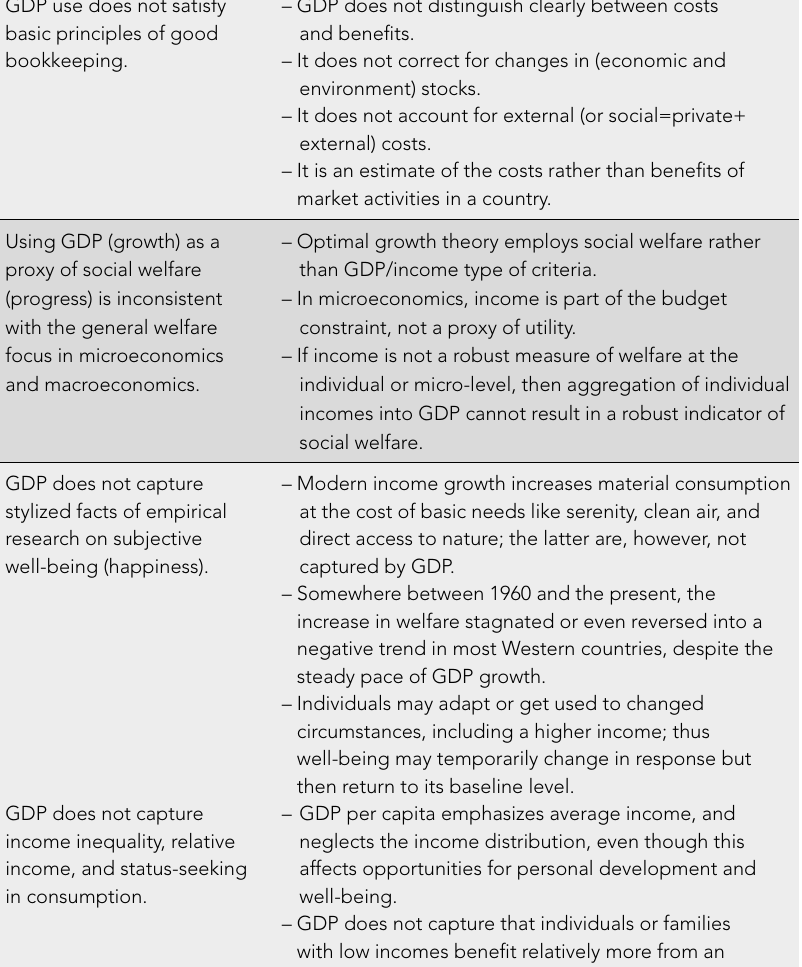
Table 1. Main shortcomings of GDP as a proxy of social welfare